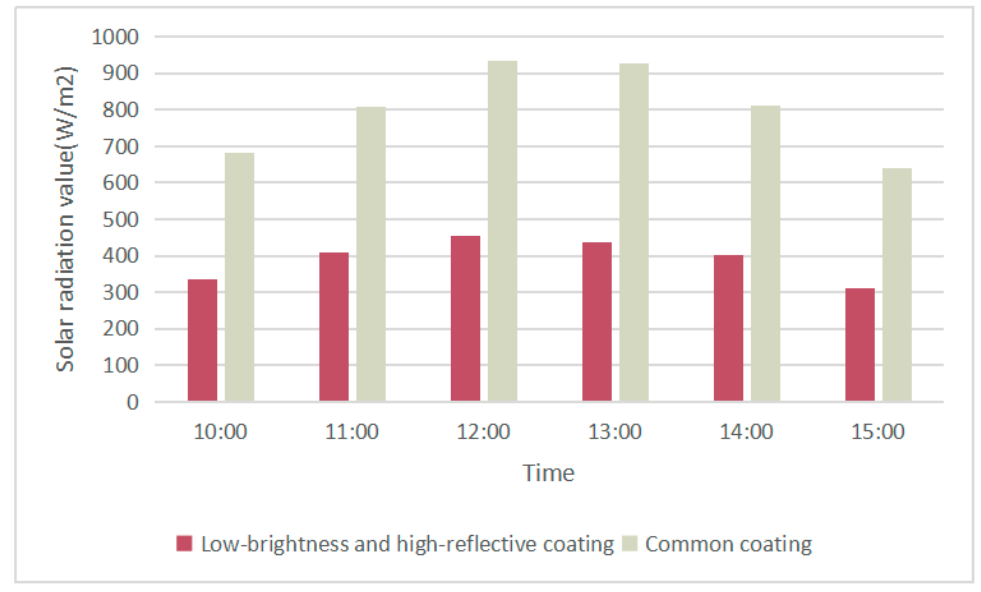
Figure 10. Solar irradiation values on the roof.